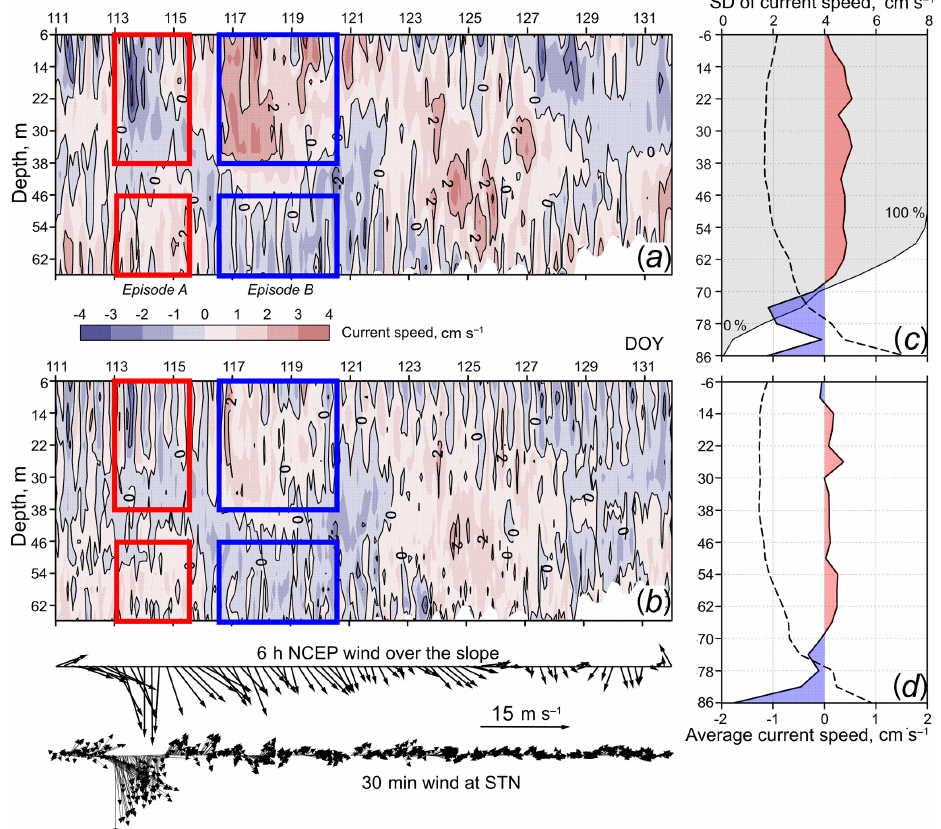
Figure 4. The temporal evolution of 2h mean (a) zonal and (b) meridional velocities (cms − 1 ) recorded between 21 April, 00:00UTC and 11 May, 21:00UTC with (c, d) their mean (solid black lines) and standard deviations (dashed black lines). Red and blue shading correspond to positive and negative velocities, respectively. The red and blue lines correspond to mean velocities measured during episode A and B, respectively. The grey shading in (c) shows the percentage of “good” current records. Blank areas in (a) and (b) mask the records with less than 50% of good data in daily records. The lower panel demonstrates (top) the 6h NCEP wind over continental slope at 82.5 ◦ N, 10.0 ◦ W and (bottom) 30min wind measured at Station